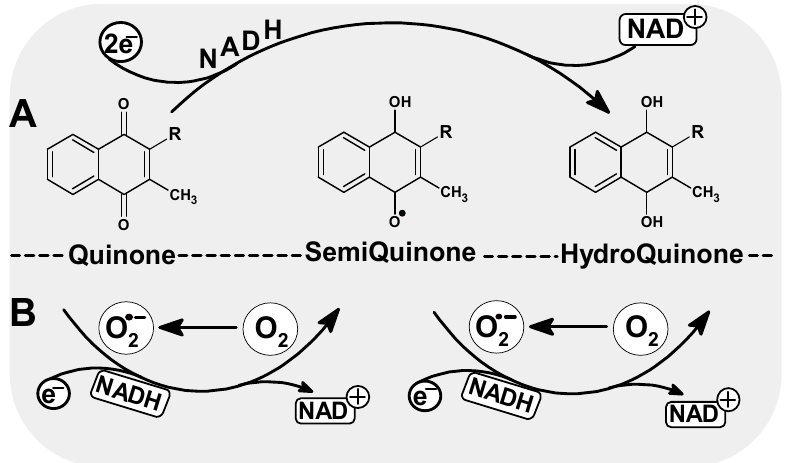
Figure 3. Possible quinone reduction reactions. A. two-electron reduction, consisting of a direct, one-step reduction to hydroquinone; this process does not generate ROS; B. single-electron reduction to form an unstable semiquinone radical. In the presence of molecular oxygen, ROS (O 2− ) can be formed in the reoxidation reaction.